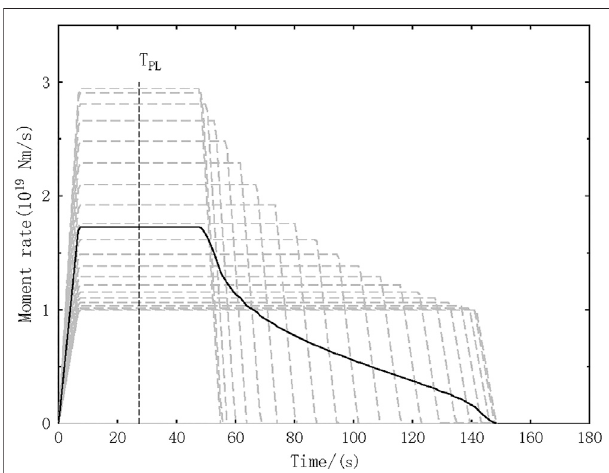
FIGURE 11 | The trapezoid-like moment rate function (MRF) and the averagedMRFwithazimuthfrom0 o to180 o .Thedashedblacklinerepresents thattheT PL oftheLPDTcurves(Plateautime)occursatthemiddlepointofthe average trapezoid plateau.